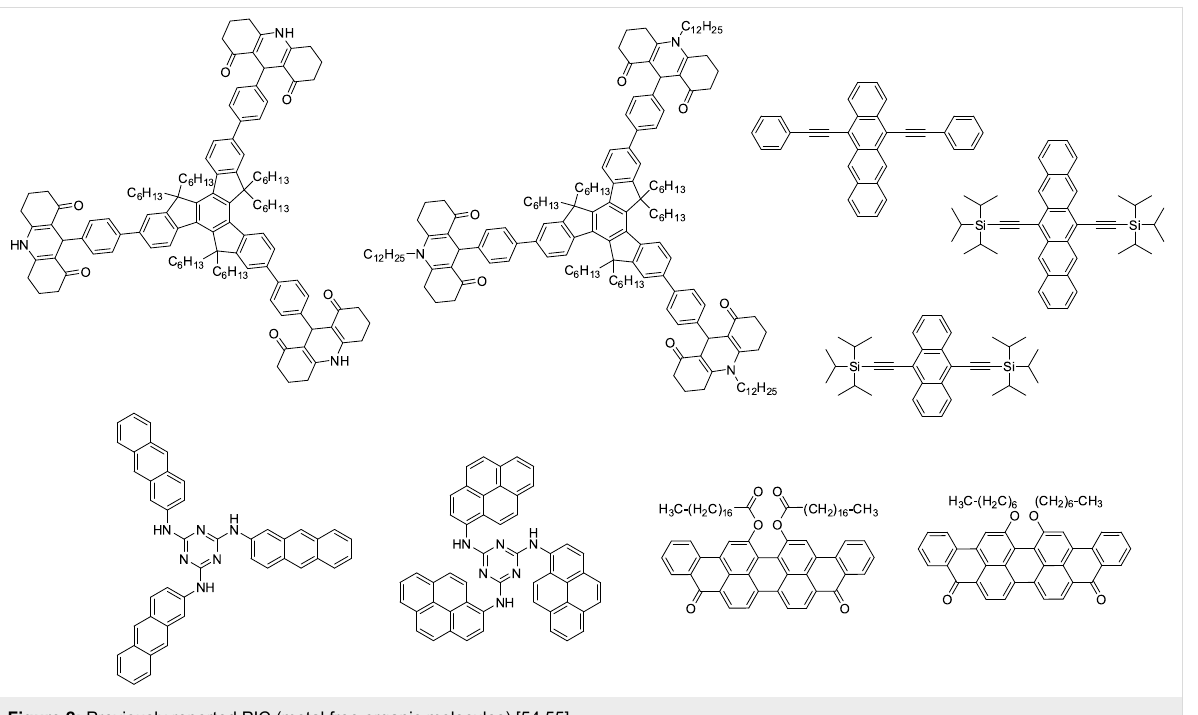
However, and with more interest, very soft irradiation condi- tions (using, e.g., household fluorescence or LED bulbs, halogen lamps or even sunlight) are also suitable to polymerize radical and cationic monomers (see Figure 4 below) under poly- chromatic or monochromatic lights in the 350–700 nm and to get tack free